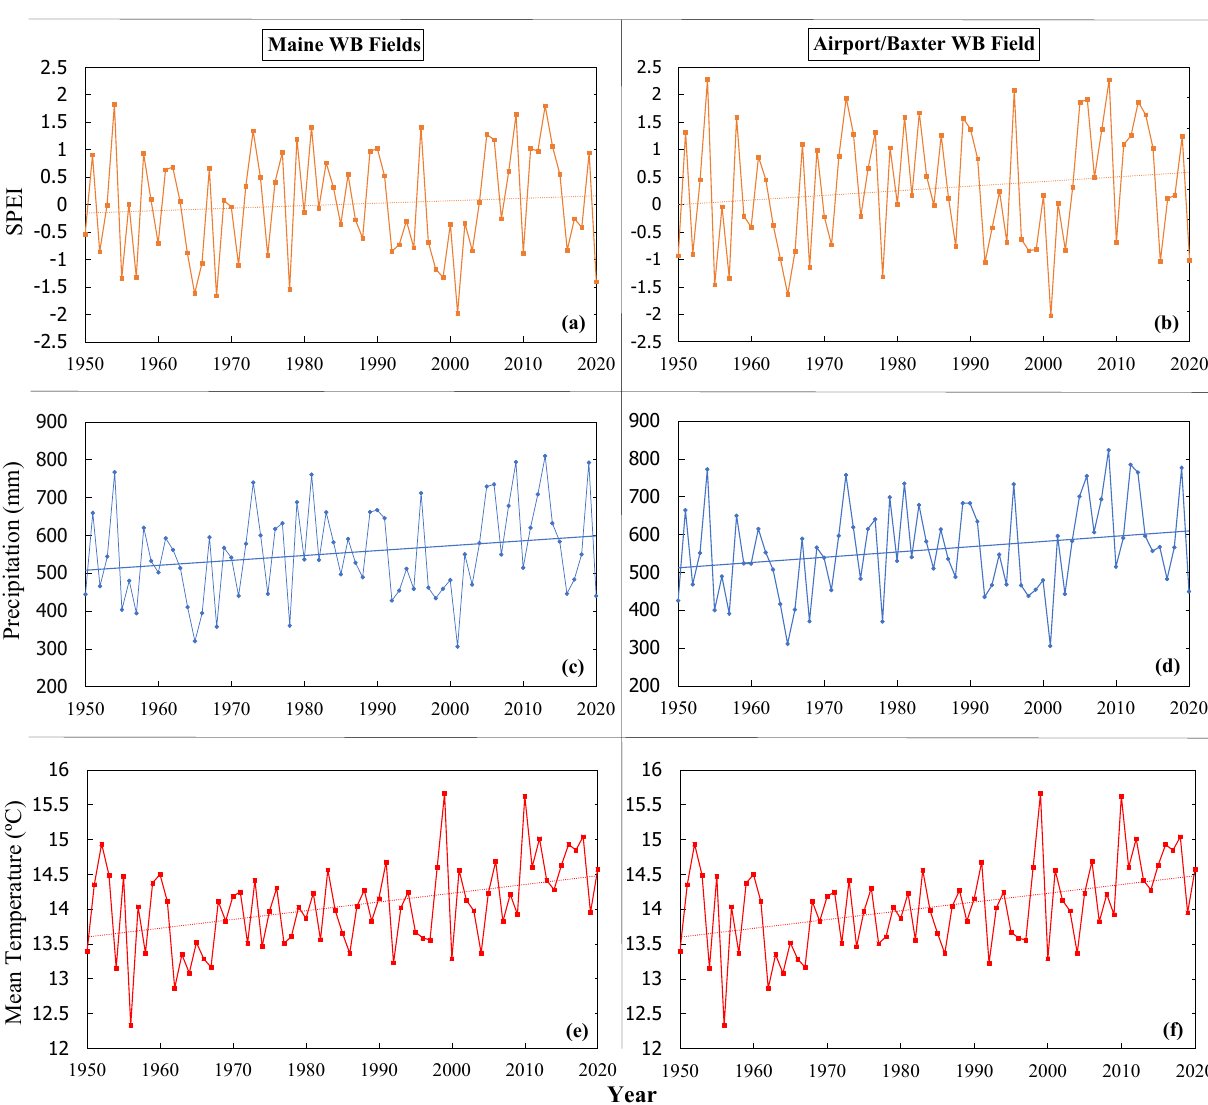
Figure 3. Historical (1950 to 2020) patterns of the ( a , b ) SPEI_6 of September; ( c , d ) mean precipitation (average of May–September); ( e , f ) average temperature (average of May–September) throughout the major wild blueberry production region in Maine as well as at the Airport/Baxter wild blueberry fields in Deblois, ME. A positive SPEI value represents wet conditions, while a negative SPEI value indicates dry conditions. Here, mean precipitation refers to an average of the monthly total precipitation (mm), and mean temperature refers to an average of the monthly air temperature at 2 m from the surface for the growing